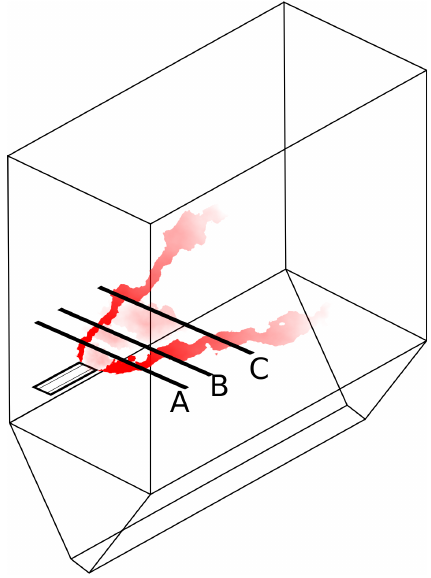
Figure 12. Schematic of the position of Traverses A, B and C within the burner geometry along with the probes placed.